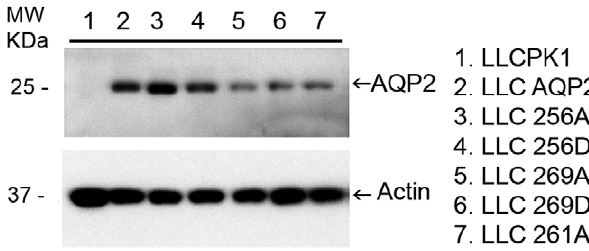
Figure 1. Expression of AQP2 and various phosphorylation mutants in LLCPK1 cells. Cell lysates were prepared from stable cells expressing WT AQP2 or AQP2 phosphorylation mutants, including S256A, S256D, S261A, S269A and S269D. Using an antibody